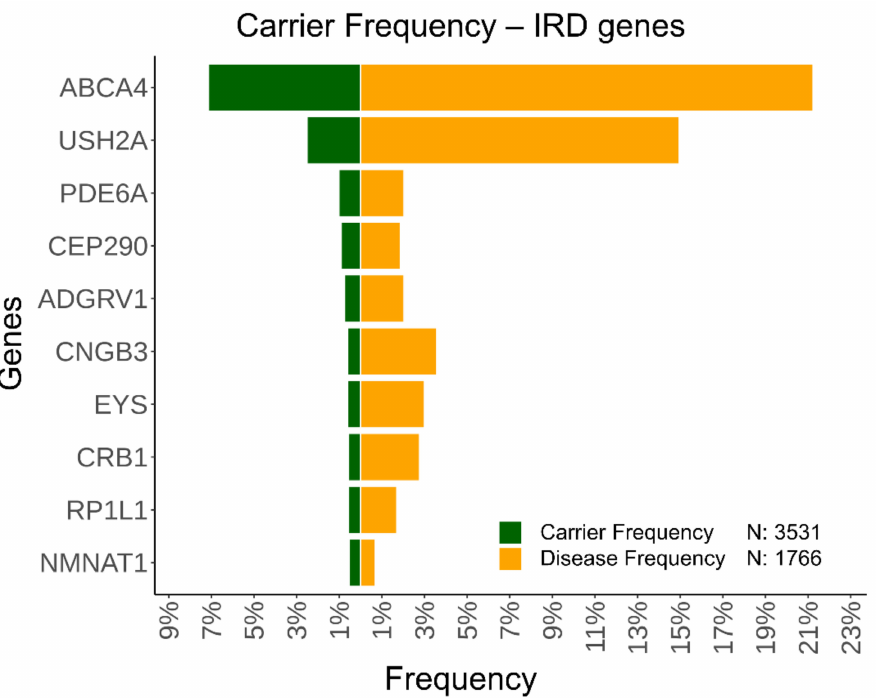
Figure 4. Carrier frequency of pathogenic variants in recessive IRD genes in pseudocontrols. The carrier frequency (CF) was calculated for all IRD genes with a recessive inheritance pattern, and at least one solved case in our cohort. Green represents the CF of the genes and orange the frequency in our IRD subcohort. The pseudocontrol subcohort was composed of 3531 cases, and the IRD subcohort had 1766 cases. The top 10 genes with higher CF are ordered